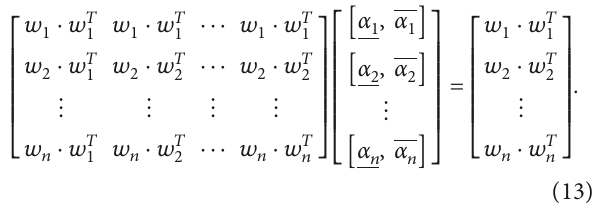
Figure 2: The process of the improved comprehensive weighting